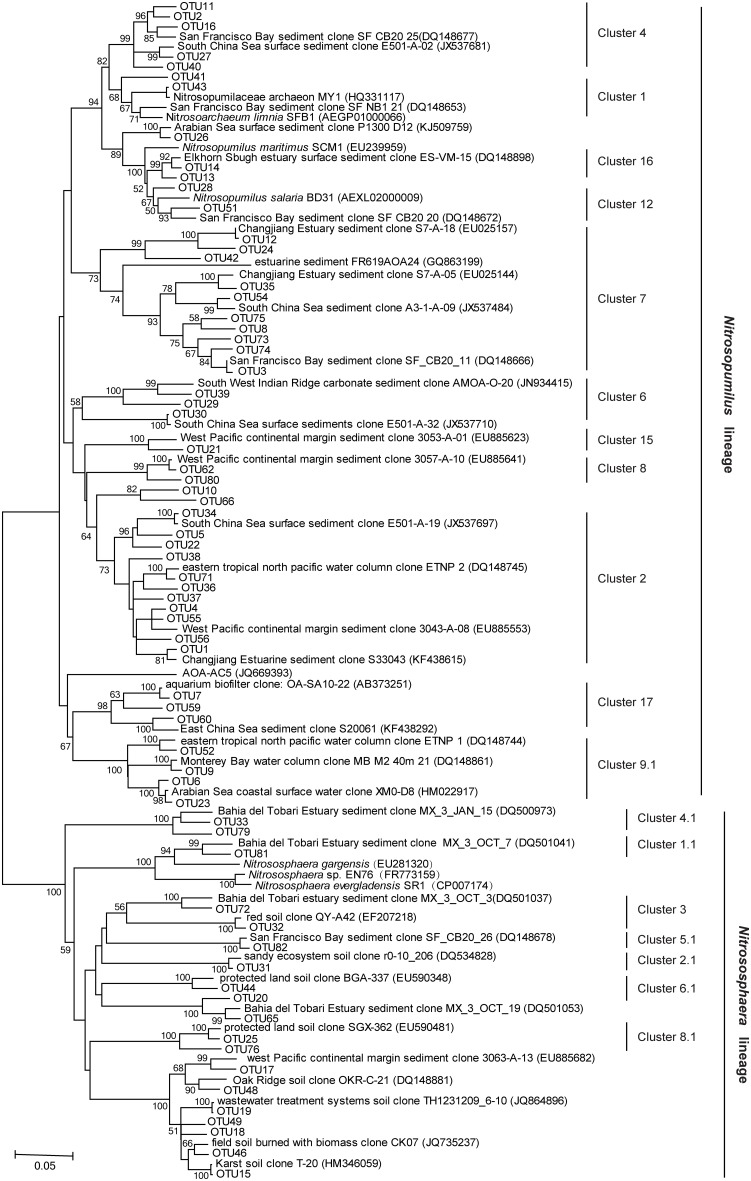
Distance-based neighbor-joining phylogenetic tree of the archaeal amoA sequences recovered from mud deposits of the eastern China marginal seas and their closest matches in GenBank. Bootstrap support values >50% (1000 replicates) are shown.